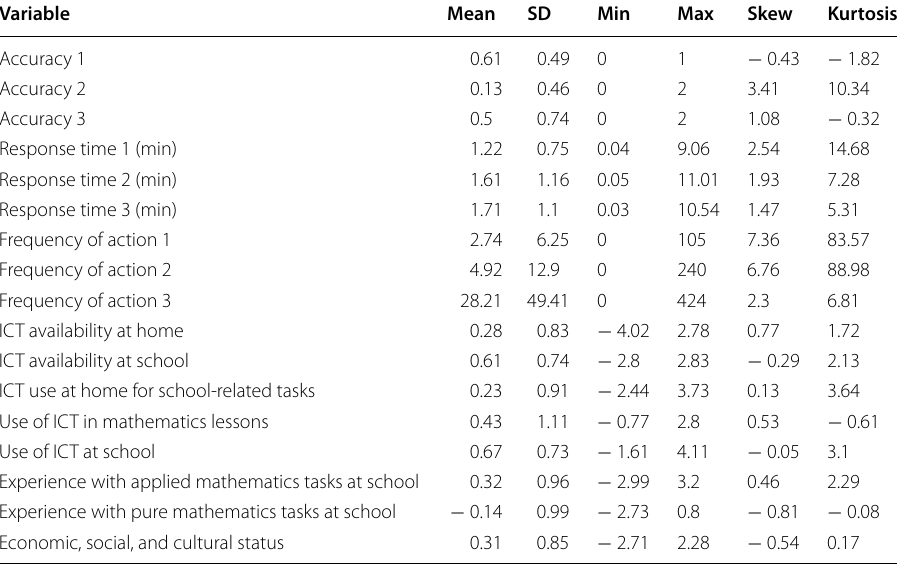
Table 5 Descriptive analysis of the indicators in their original metrics